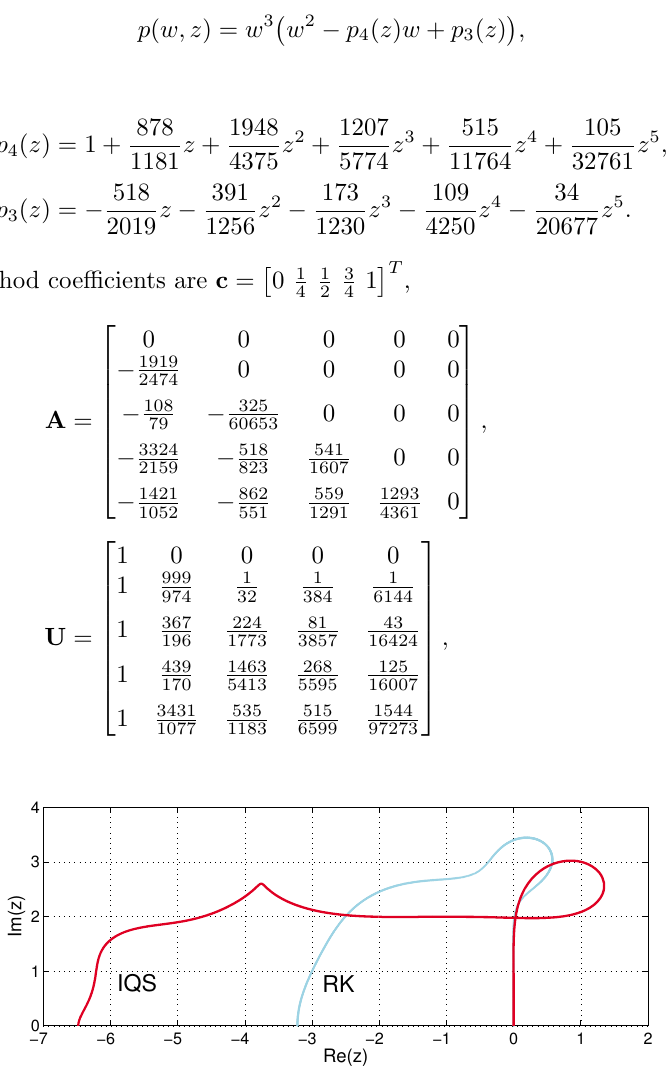
Figure 4. Stability regions of RK method of order p = 5 and GLMs with s = r = p = 5, q = 4 with